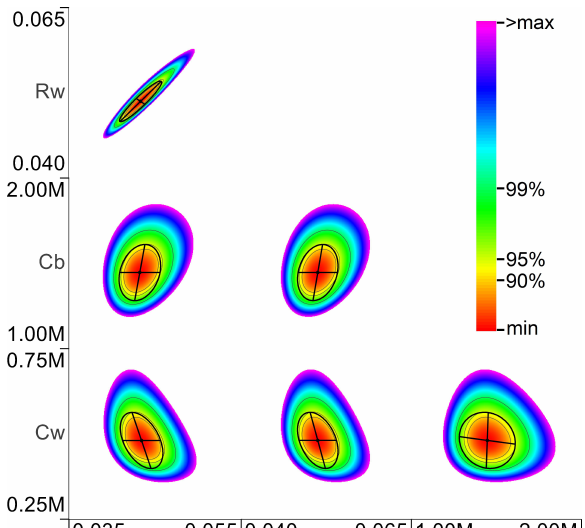
Figure 22: PL2 and Hessian ellipses (thick black) for the R2C2 model. Iso-lines trace the 90%, 95% and 99% confidence bounds computed from the PL2 results, based on the χ 2 distribution with n df = 2. The Hessian method is used to compute Σ θ and super- impose an elliptic approximate confidence region at α =